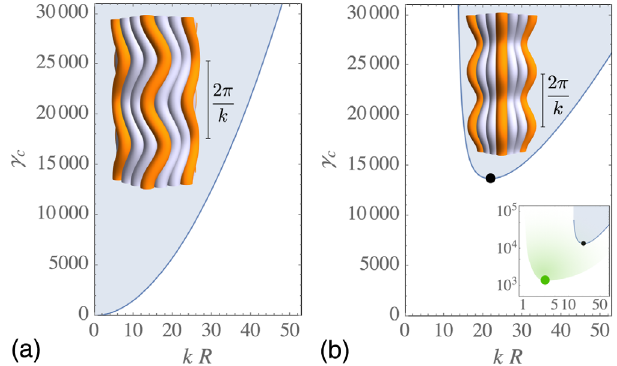
FIG. 2. The stability map of torsional wrinkles for a bundle in terms of the wave vector k and the fil-vK number γ . Above this line, bundles are unstable to torsional wrinkling. Visualizations of the unstable modes are shown for each case. (a) A fivefold disclination yields a stability range that decreases to zero in the long-wavelength limit of k → 0 , i.e., homogeneous pitch. (b) Al- ternatively, a sevenfold disclination is unstable to splay undu- lations. The minimum γ unstable mode (black dot) occurs for kR ¼ 21 . 8 and γ ¼ 13685 . The inset shows a schematic com- c parison between the axisymmetric instability and the γ c corre- sponding to the nonaxisymmetric shape modes explored by the discrete filament simulations (green dot), analyzed in Sec. III B and extrapolated to the L → ∞